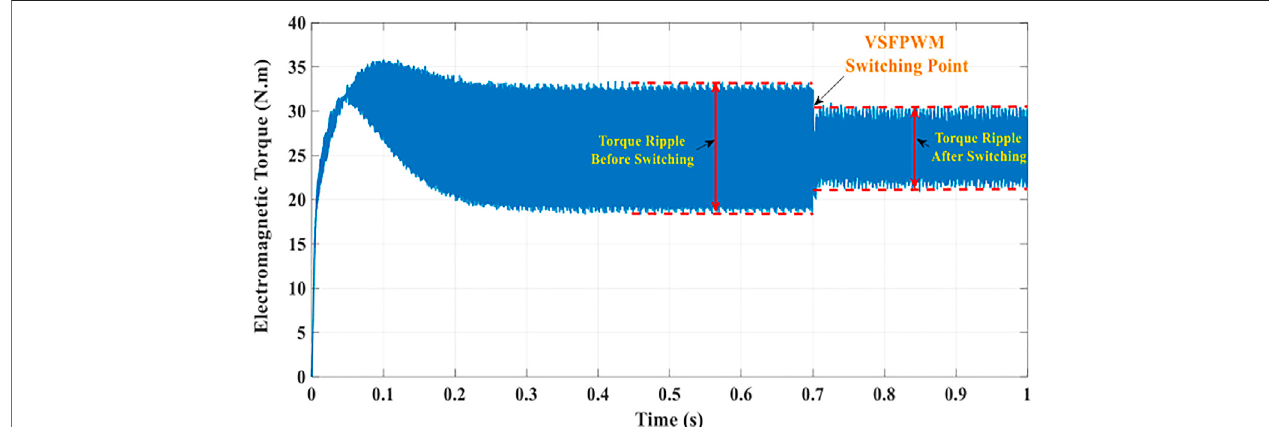
FIGURE 6 | Torque response.